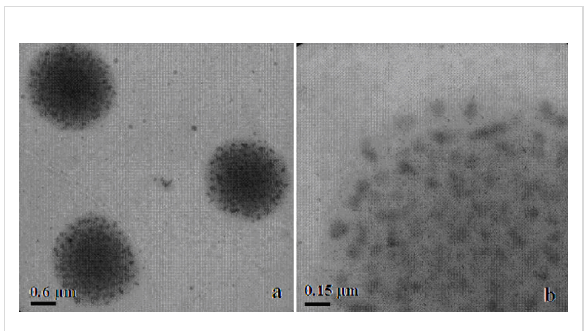
Figure 8: TEM images of agglomerated particles of SnO 2 in different magnifications.